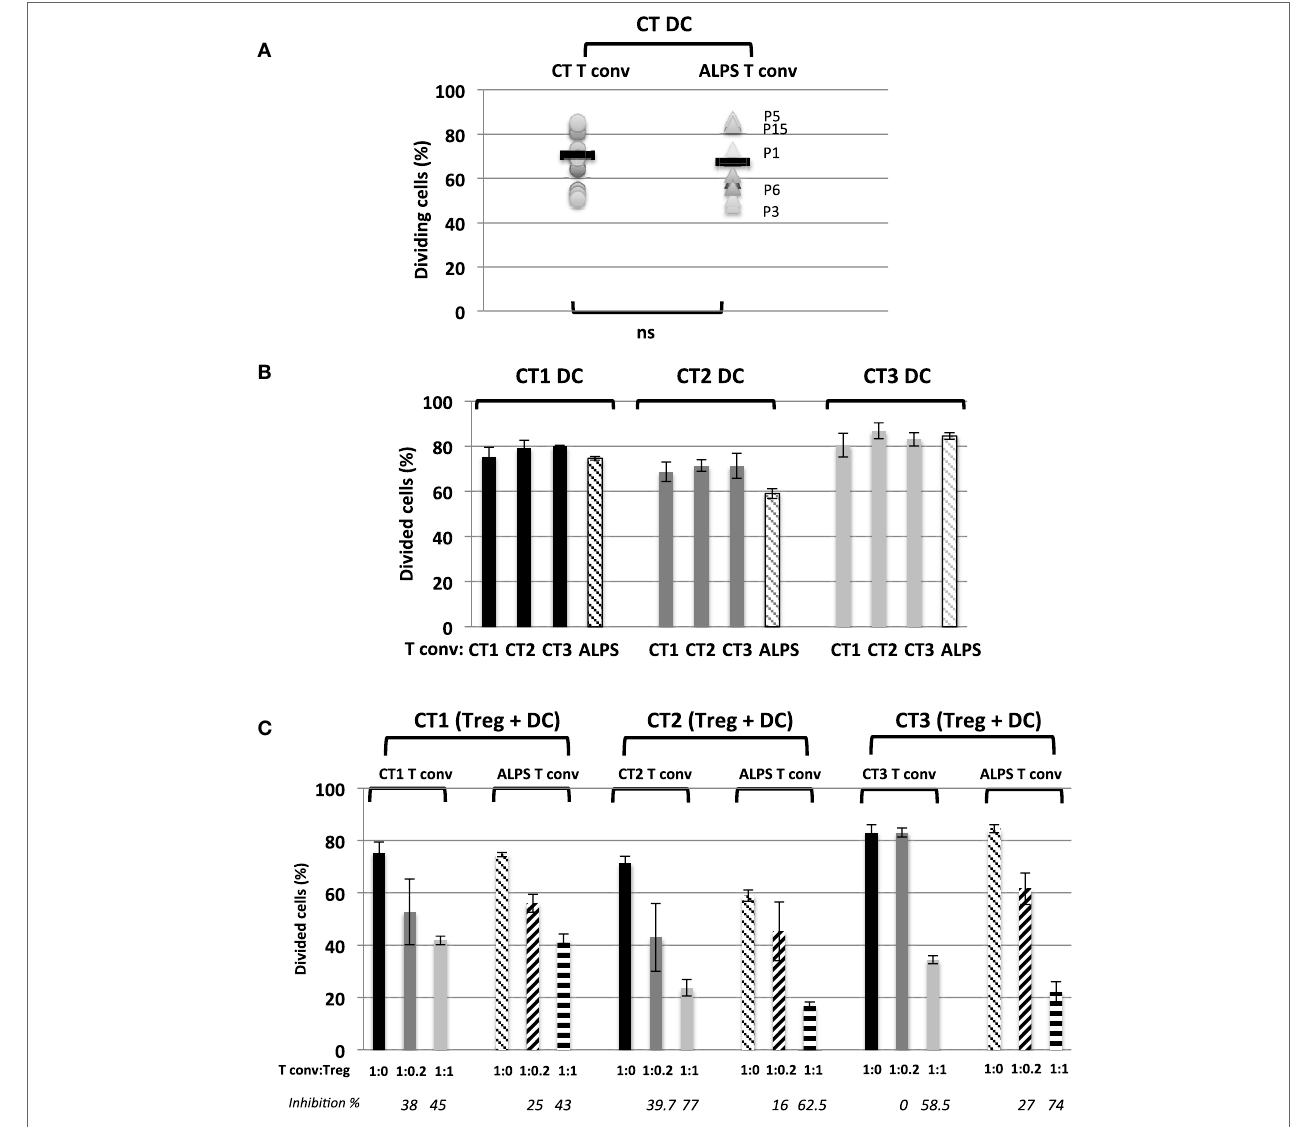
FigUre 5 | Activation and regulation of naïve conventional effector T cell (Tconvs) from autoimmune lymphoproliferative syndrome (ALPS) patients induced by a CD4 low CD11c + CD14 − dendritic cell (DC) subpopulation from three healthy controls (CTs). (a) shows the proportion of proliferating naïve Tconvs from health controls (CTs) or from ALPS patients (ALPS Tconvs) incubated with staphylococcal enterotoxin E (SEE) and DCs from CTs (CT DC). The mean ± SD (range) proportion of CT Tconvs activated by CT DCs was 70 ± 12% (51–85.6%) ( n = 13) and the mean ± SD (range) proportion of ALPS Tconvs activated by CT DCs was 67.4 ± 15.3% (48.3–87%) ( n = 9). (b) shows the proportion of proliferating naïve Tconvs from three CTs (CT1, CT2, and CT3) and staining with carboxyfluorescein succinimidyl ester (CFSE) and incubation for 5 days with SEE and either DCs from three different CTs (CT1, CT2, and CT3) or DCs from ALPS patients. (c) shows the results